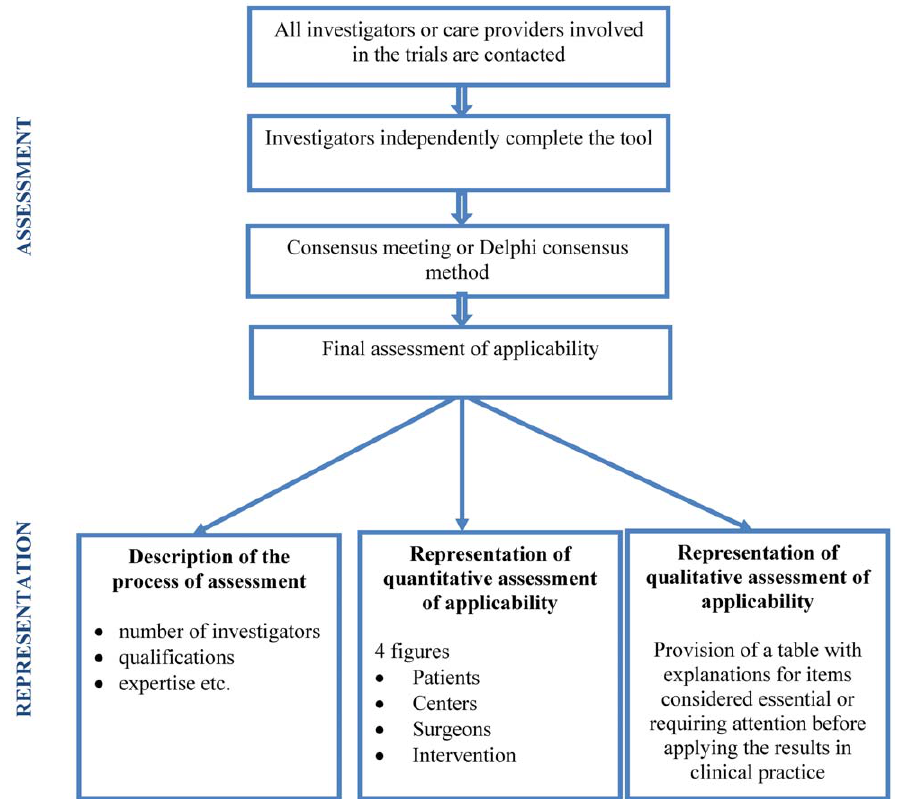
Figure 2. How the tool should be used.